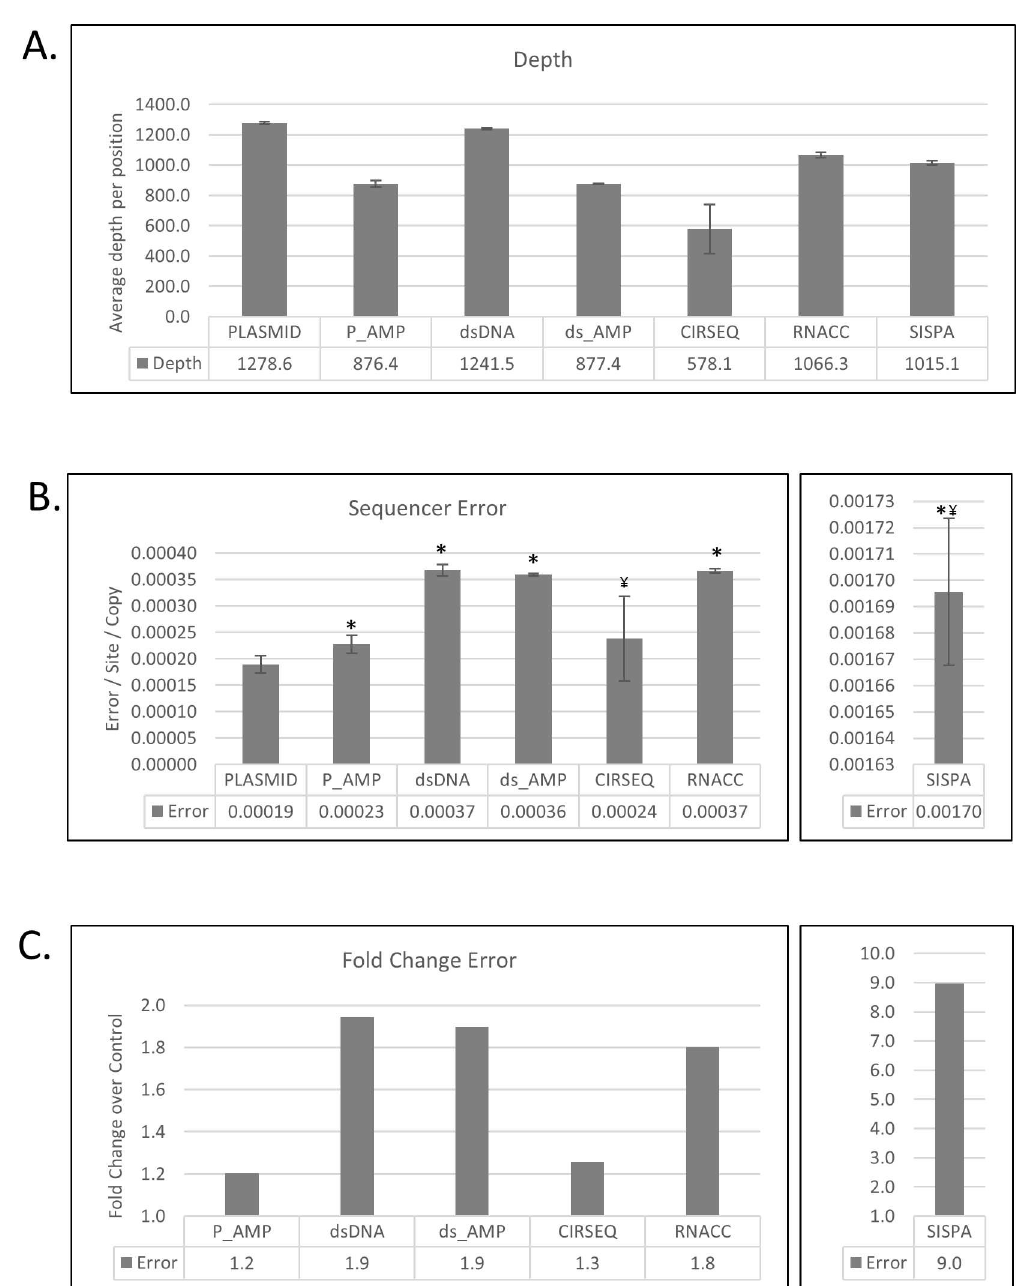
Fig 2. Total error by sample preparation method. (A) The mean read depth per positionfrom two DNA controls (PLASMID and P_AMP) and five RNA sample preparation methods (n = 2 of replicateexperiments). (B) Errors calculatedas error/site/copy (plasmidor transcript) are presentedas the averageof duplicateexperiments as in A. Intra-host single nucleotide variants present in the originalplasmidwere removedfrom the calculationof the error (referencepositions:4,697 and 4,725). Student t-tests were performed to demonstrate differences betweenthe mean error per site per copy in the control plasmid( * = p < 0.05)and each sample preparation method. (C) The error calculatedin B is converted to fold change over the control (“PLASMID”). Error bars in all panels represent standard deviationof the mean.